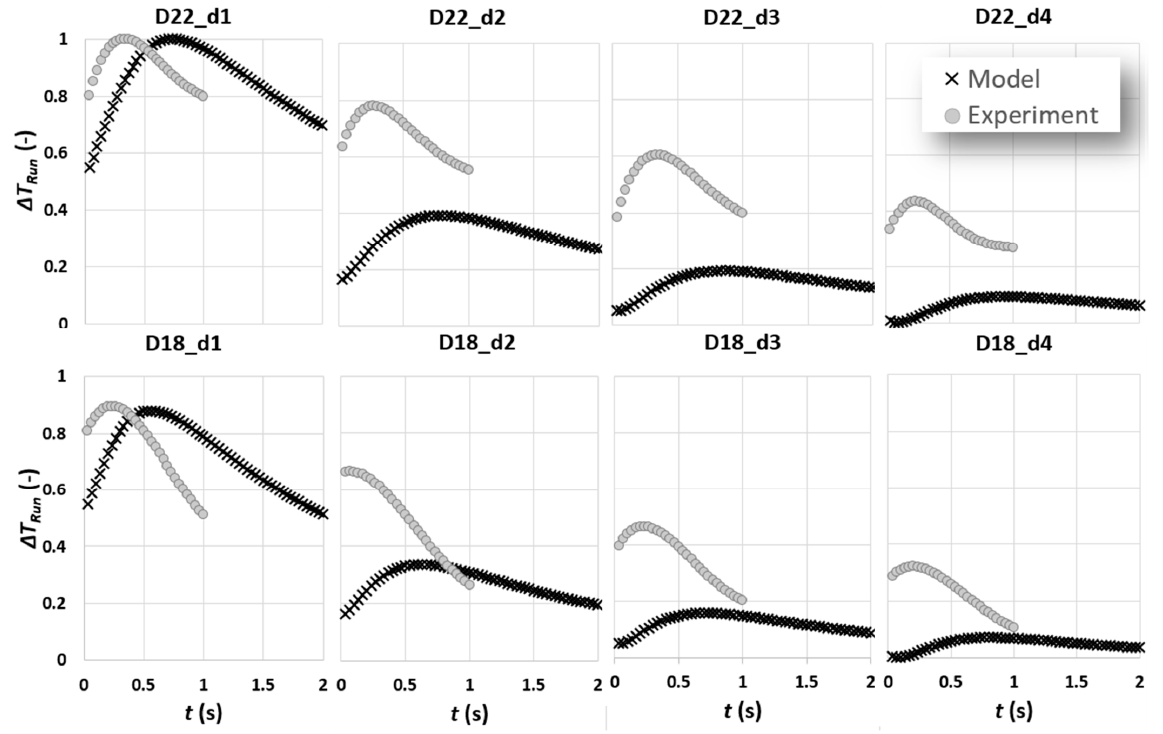
Figure 12. A comparison between experimental results and analytical model for defects of diameter 22 and 18 mm for various depths.